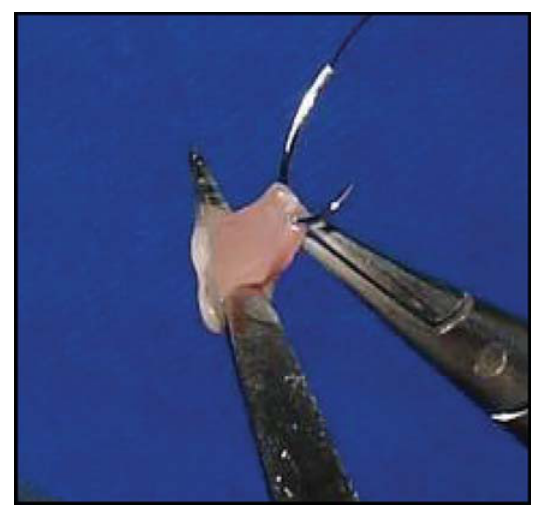
FIGURE 1 - Photomicrography of the left uterine horn patch, during 6-0 nylon stitch passing through the patch